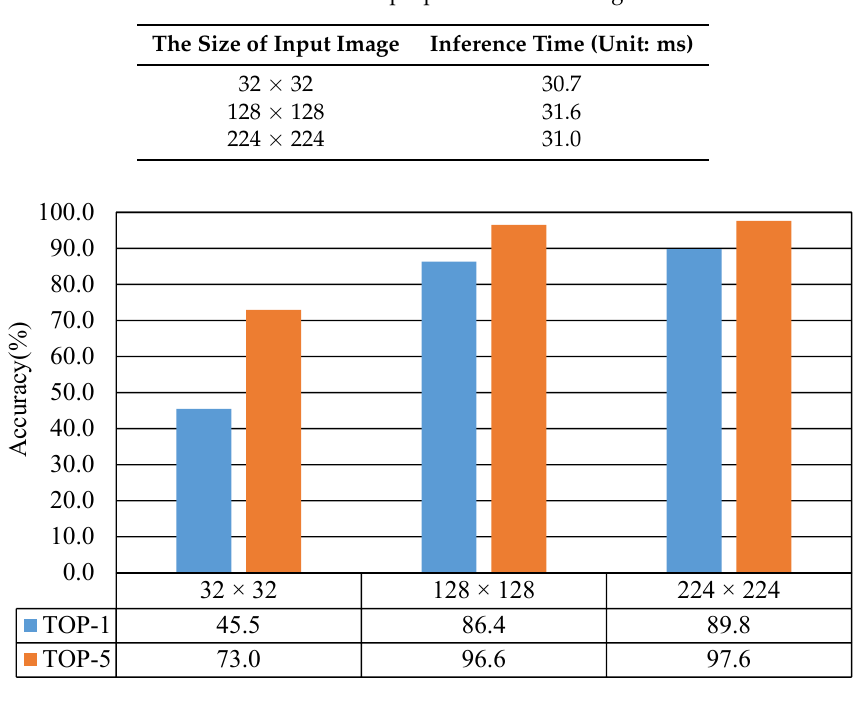
Table 5. Inference time of the proposed Caoshu recognition model.